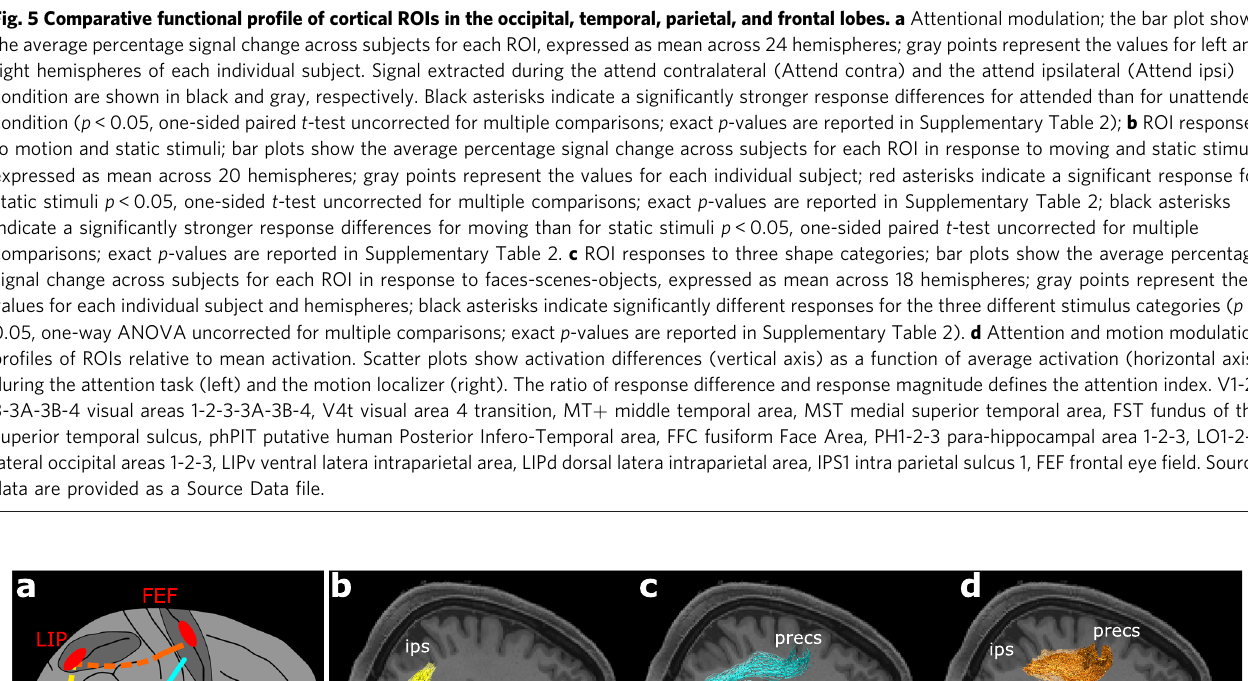
Fig. 5 Comparative functional pro fi le of cortical ROIs in the occipital, temporal, parietal, and frontal lobes. a Attentional modulation; the bar plot shows the average percentage signal change across subjects for each ROI, expressed as mean across 24 hemispheres; gray points represent the values for left and right hemispheres of each individual subject. Signal extracted during the attend contralateral (Attend contra) and the attend ipsilateral (Attend ipsi) condition are shown in black and gray, respectively. Black asterisks indicate a signi fi cantly stronger response differences for attended than for unattended condition ( p < 0.05, one-sided paired t- test uncorrected for multiple comparisons; exact p -values are reported in Supplementary Table 2); b ROI responses to motion and static stimuli; bar plots show the average percentage signal change across subjects for each ROI in response to moving and static stimuli, expressed as mean across 20 hemispheres; gray points represent the values for each individual subject; red asterisks indicate a signi fi cant response for static stimuli p < 0.05, one-sided t- test uncorrected for multiple comparisons; exact p -values are reported in Supplementary Table 2; black asterisks indicate a signi fi cantly stronger response differences for moving than for static stimuli p < 0.05, one-sided paired t- test uncorrected for multiple comparisons; exact p -values are reported in Supplementary Table 2. c ROI responses to three shape categories; bar plots show the average percentage signal change across subjects for each ROI in response to faces-scenes-objects, expressed as mean across 18 hemispheres; gray points represent the values for each individual subject and hemispheres; black asterisks indicate signi fi cantly different responses for the three different stimulus categories ( p < 0.05, one-way ANOVA uncorrected for multiple comparisons; exact p -values are reported in Supplementary Table 2). d Attention and motion modulation pro fi les of ROIs relative to mean activation. Scatter plots show activation differences (vertical axis) as a function of average activation (horizontal axis) during the attention task (left) and the motion localizer (right). The ratio of response difference and response magnitude de fi nes the attention index. V1-2- 3-3A-3B-4 visual areas 1-2-3-3A-3B-4, V4t visual area 4 transition, MT + middle temporal area, MST medial superior temporal area, FST fundus of the